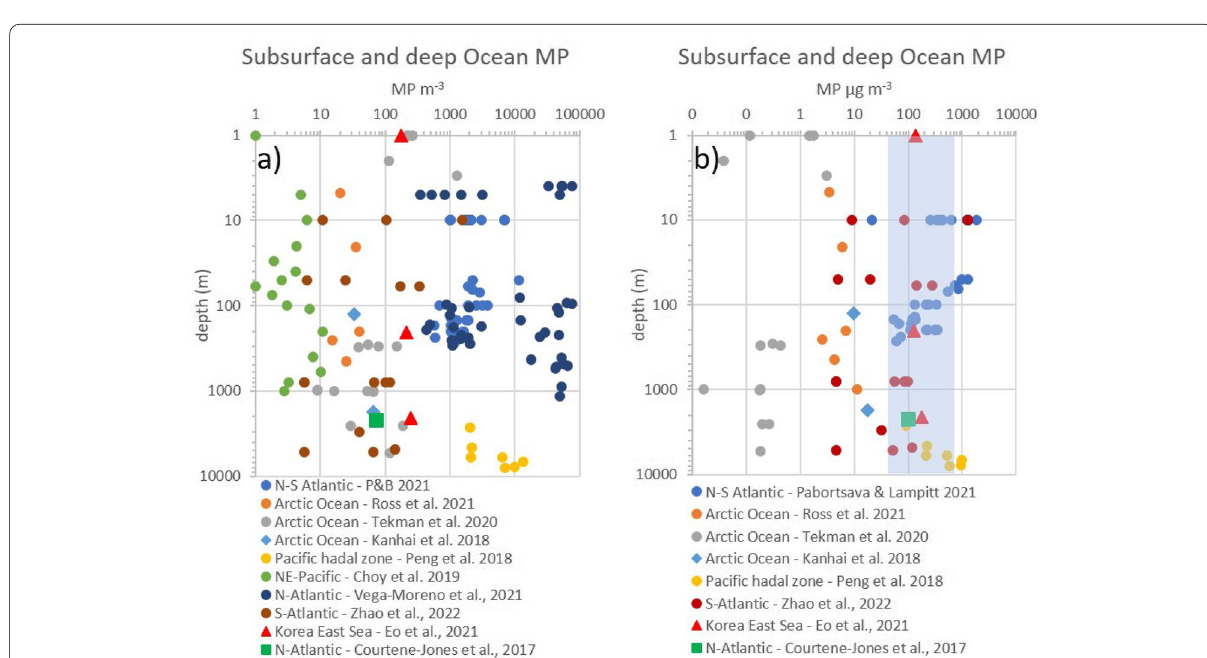
Fig. 2 Subsurface Ocean microplastics (MP LMP SMP) observations. A MP number concentrations per m 3 of sea water. B MP mass = + concentrations for datasets where particle/fiber size distribution was reported (see Methods). The shaded vertical bar indicates the range of mean 1σ mass concentrations estimated for the Pacific and Atlantic Oceans (45 to 175 μg m − 3 , Table ±